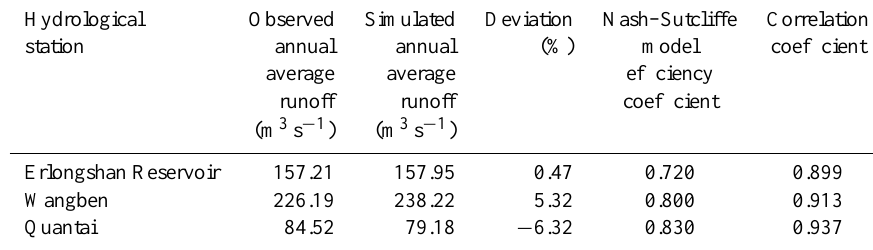
Table 4. Comparing the simulated and observed monthly runoff from 1960 to 2000.